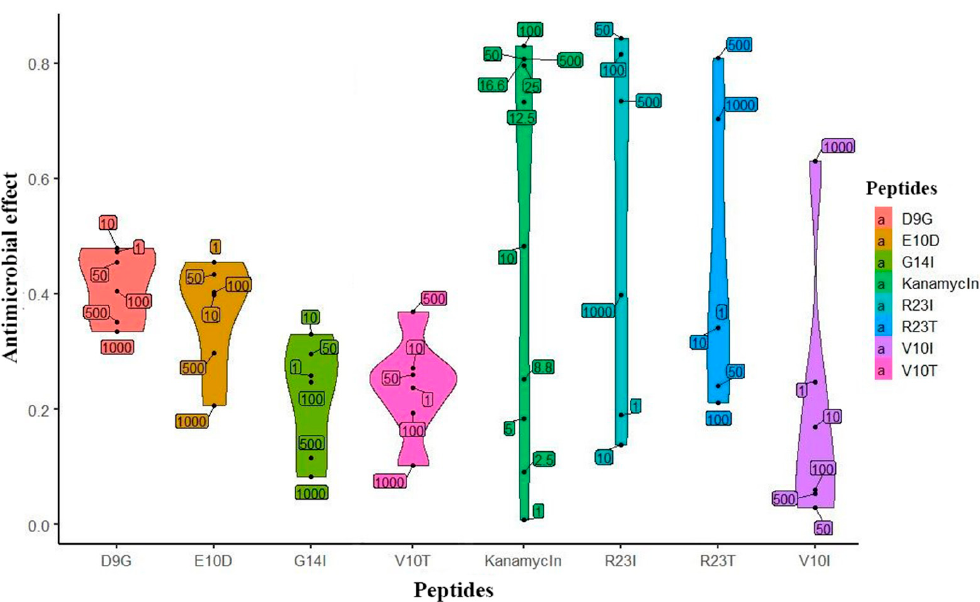
Figure 3. Violin plot of the effect distribution versus peptide concentration. Peptides are located on the abscissa, and the effect is on the ordinate. The upper and lower borders on shapes are show the 95% confidence intervals. The width of the figure shows the frequency of observation of points. Numeric labels with black dots in the plot area reflect the actual concentration of the peptide ( μ g/mL).